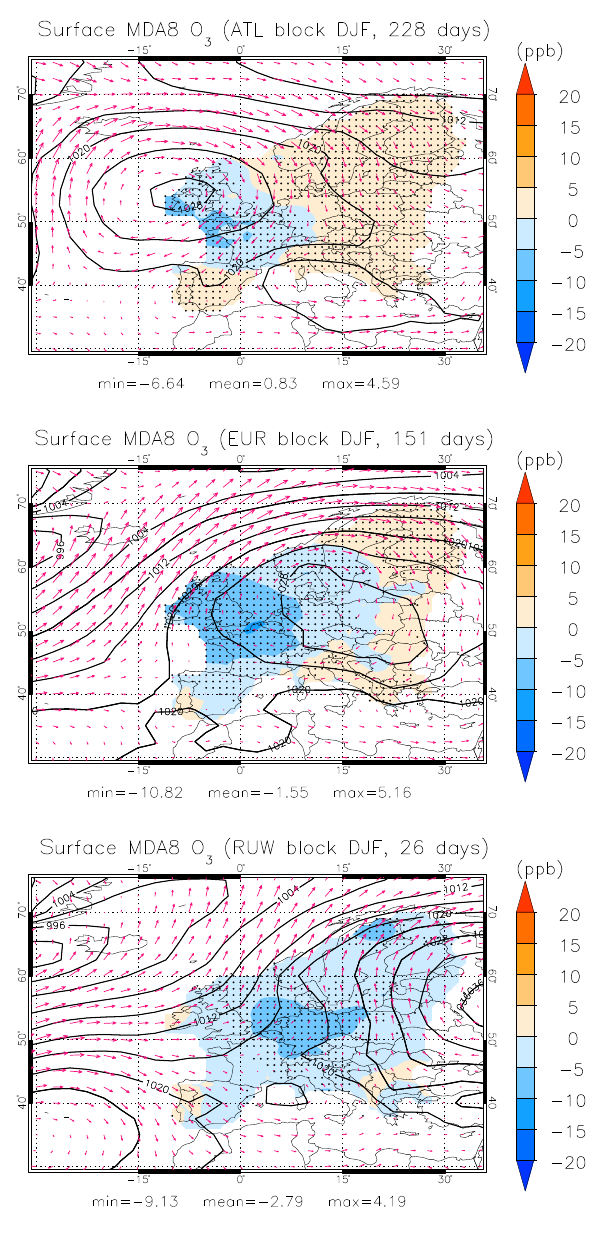
Figure 10. As Fig. 4 but for blocking centres remaining in the At- lantic (30–0 ◦ W, top) and European (0–30 ◦ E, middle) sectors as well as in the west flank of the Russian sector (30–45 ◦ E, bottom) in